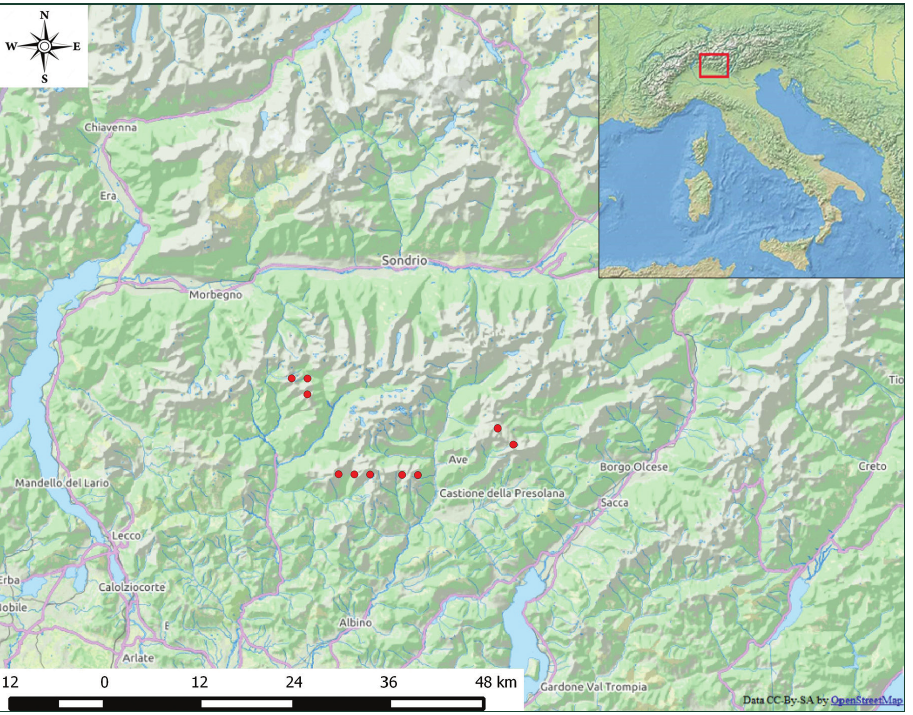
Figure 2. Geographic range and distribution map of Linaria tonzigii